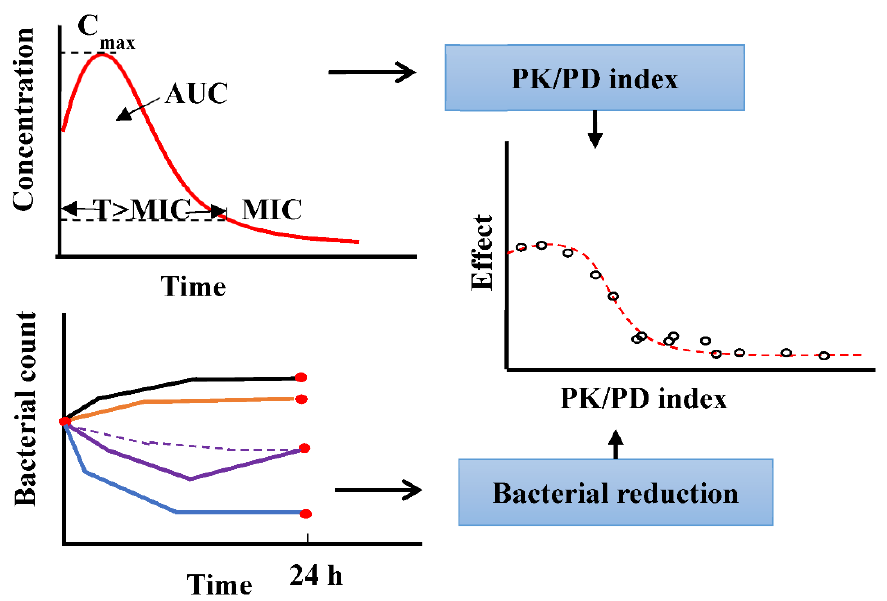
Figure 1. Method to derive the PK/PD index using the empirical PK/PD model.